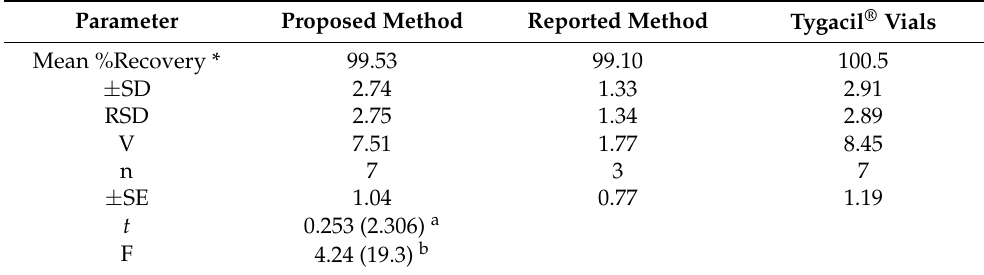
Table 7. A comparison between the proposed and the reported [17] methods for the determination of TIGC using TCNQ in the pure form and in the